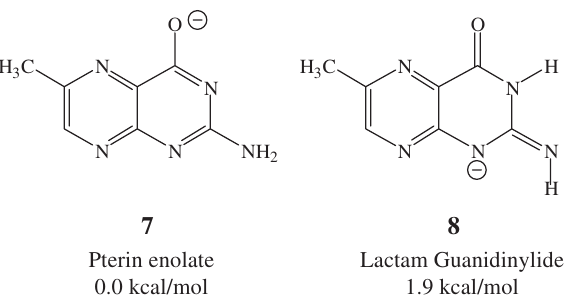
Figure 3 Calculated relative energies of anionic pterin structures [23] (B3LYP/6-31+G*//B3LYP/3-21G* level of theory and PCM water